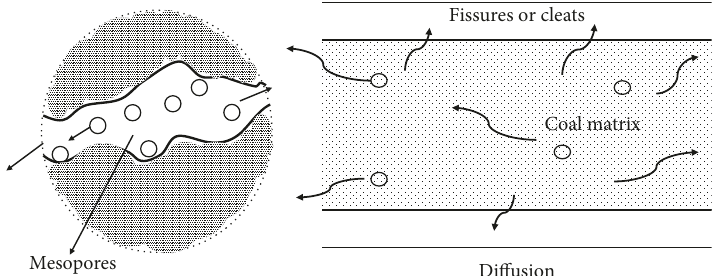
Figure 1: Schematic diagram of the coal desorption